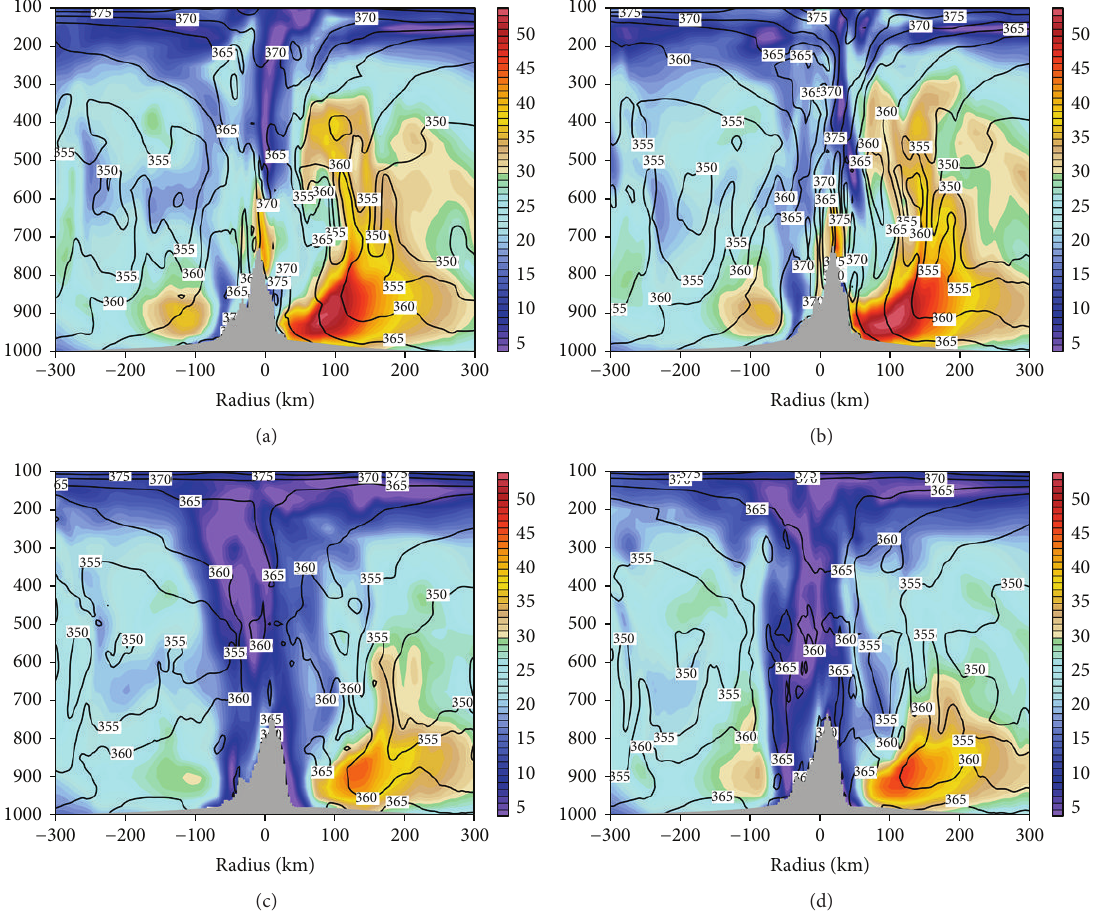
Figure 8: West-east cross sections of equivalent potential temperature ( 𝜃 𝑒 , units: K) from (a) CTRL, (b) No hflux, (c) No qflux, and (d) No flux at intervals of 3 K, superposed with wind velocity (units: m s −1 ) at 1200 UTC 18 July